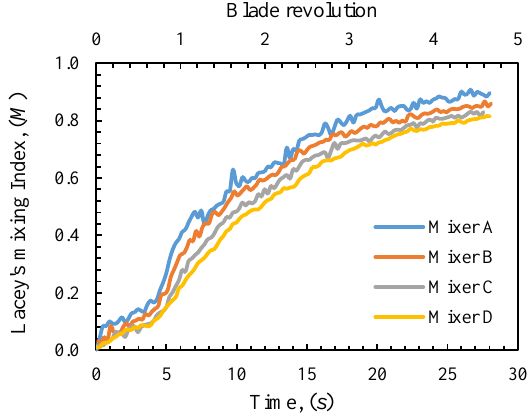
Fig.2 : The evolution of Lacey’s mixing index, M as a function of time or blade revolution for all mixers at 10 RPM.